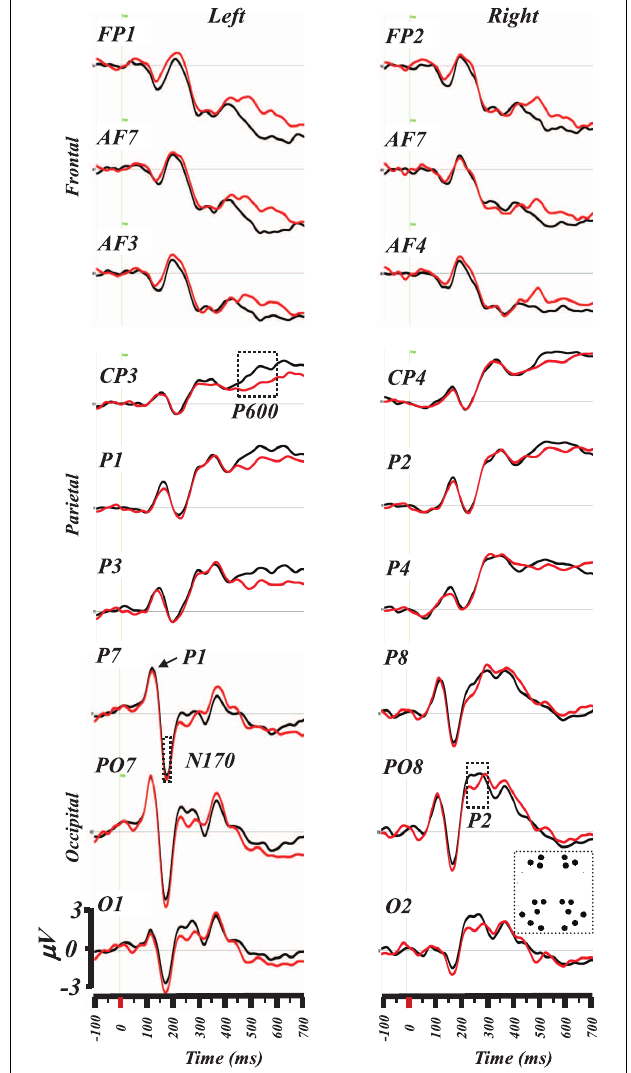
FIGURE 2 | Superimposition of grand-mean ERP (from − 100 to 700ms post-stimulus) induced by words (black traces) and PHw (red traces). The selected electrodes represent antero-posteriorly distributed left and right electrodes where differences were maximally evident for the N170 and P2 components at electrodes PO7 and O1 (left) and PO8 and O2 (right). Note the succession of the P1and the N170 components on P7. The differences during the P6 component are best illustrated on centro-parietal electrodes (see CP3). The inset in lower left depicts the location of the selected electrodes (see text for